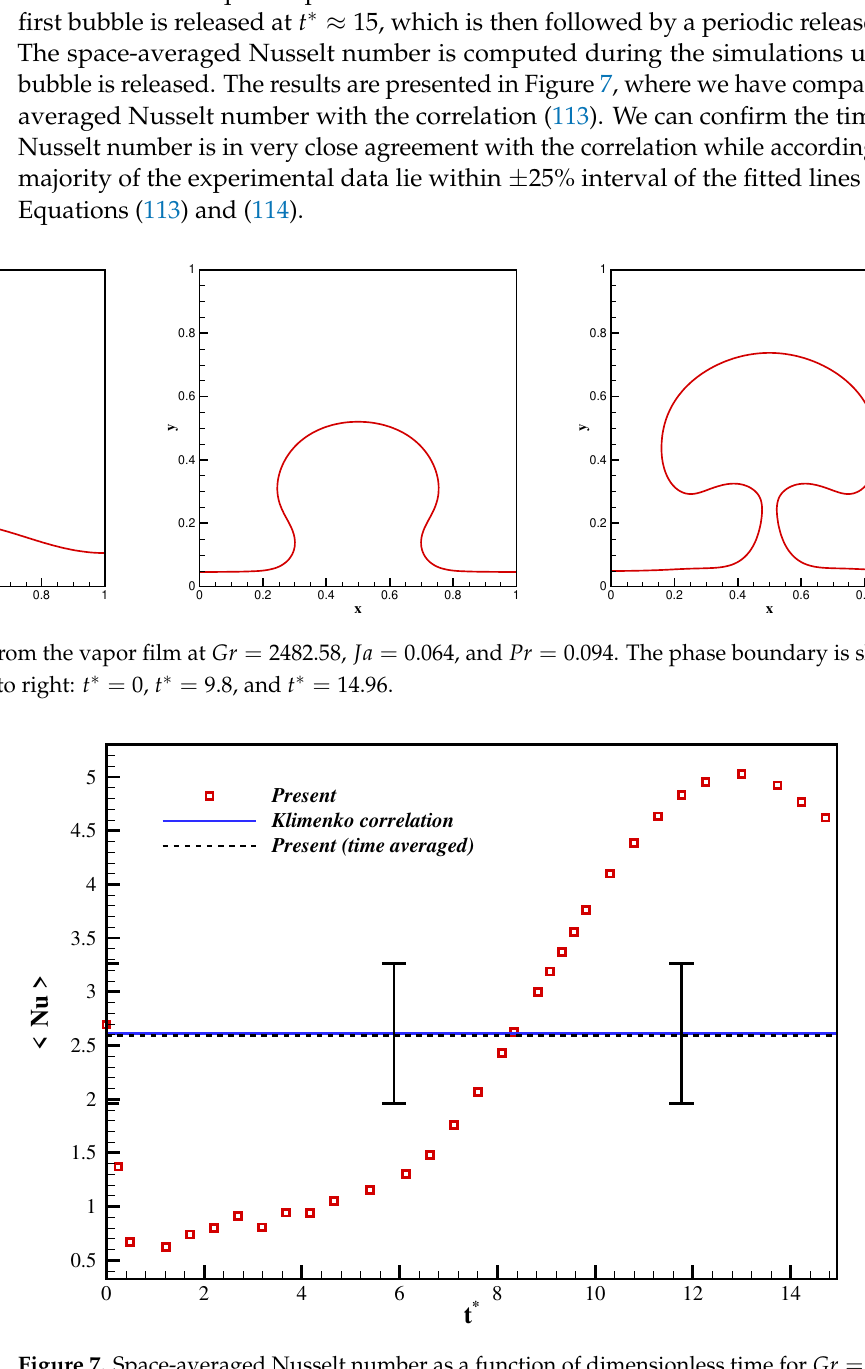
Figure 7. Space-averaged Nusselt number as a function of dimensionless time for Gr = 2482.58, Ja = 0.064, and Pr = 0.094. The error bars amount to ± 25% acceptable error as shown by Klimenko